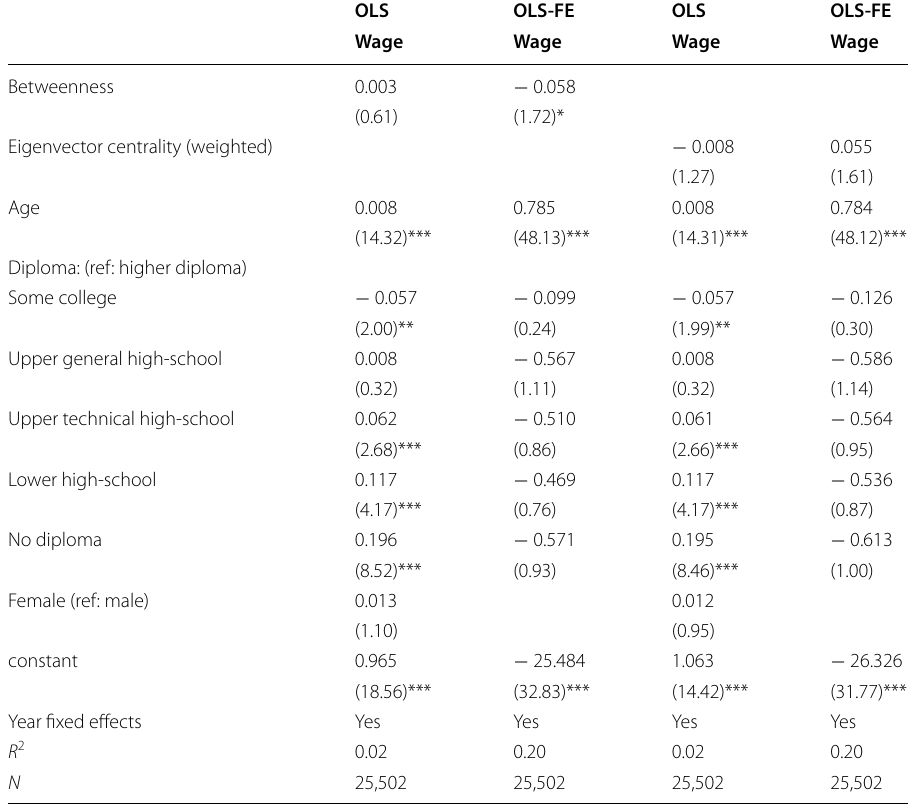
Table 8 Alternative centrality measures and unemployment duration